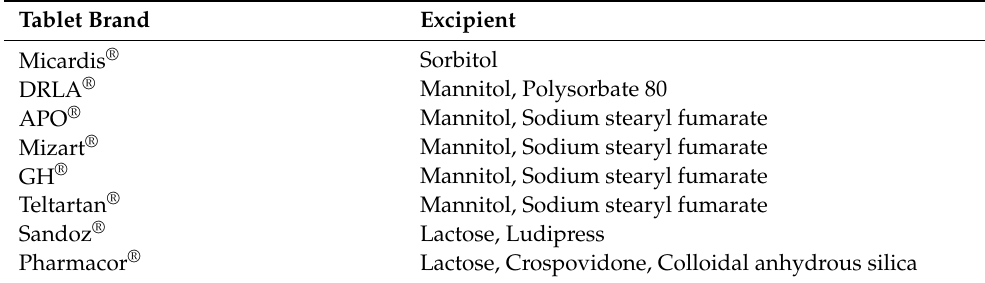
Table 1. Comparison of different excipients present in telmisartan tablet brands (NB: all brands also contained povidone, meglumine, sodium hydroxide, and magnesium stearate)